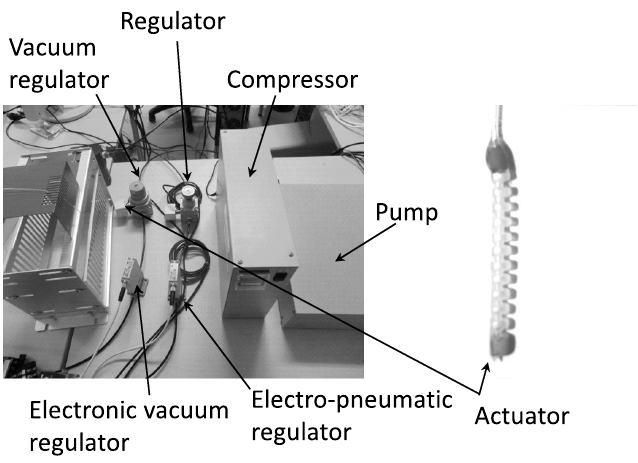
Figure 9. Experimental system and actuator.